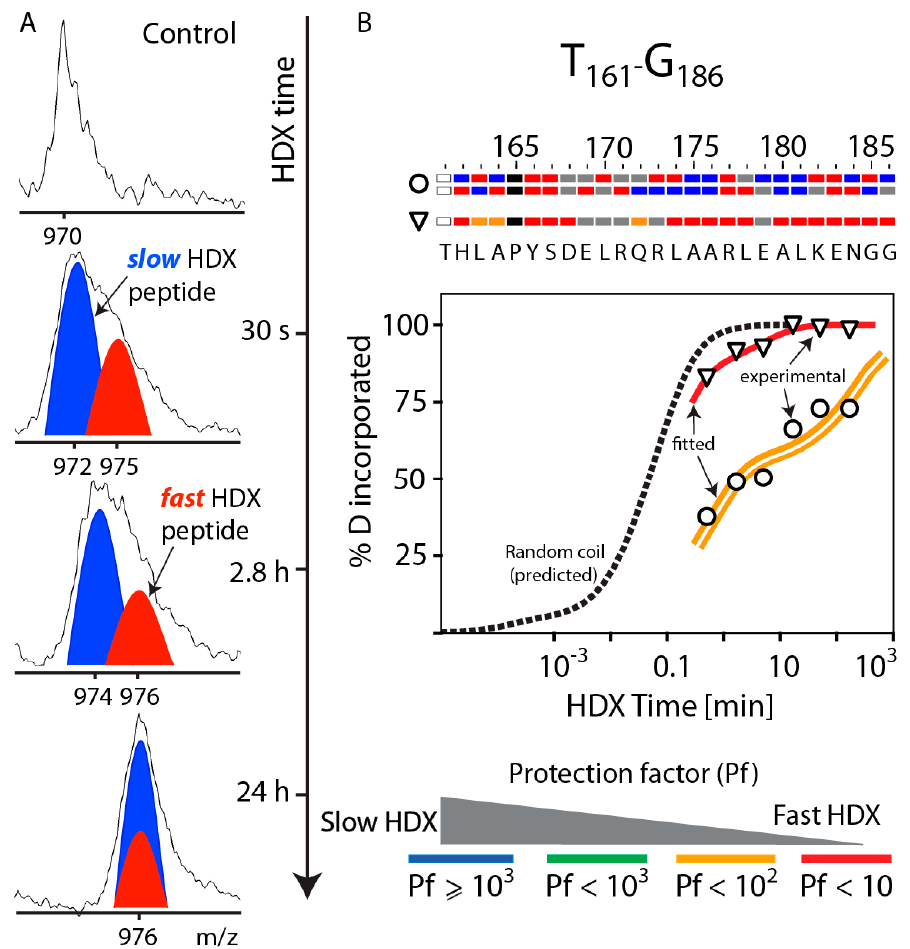
Figure 3. Bimodal and biphasic HDX kinetics of apoA-I peptide T 161 –G 186 in rsHDL. ( A ), MS spectra at various HDX times were “partitioned” into “spectra” (colored cartoons) for slow (blue) and fast (red) H / D exchanging protein domains. The peak centroids for the two protein domains merged over time, as the slower HDX domain became fully deuterated. The abundance of the peptide corresponding to the slower HDX domain was estimated to be about twice that of the peptide corresponding to the faster HDX domain. ( B ), Kinetic analysis of the HDX-MS spectra: the dotted black line displayed D incorporation in the T 161 –G 186 domain of apoA-I if in random coil conformation. The experimental D incorporation for T 161 –G 186 were shown with open circles (slow HDX) and open triangles (fast HDX), and the stretched exponential functions fitted to the experimental values (open circles and triangles) were the red and orange curves, respectively. The fact that the slow exchanging domain produces peptides twice as abundant as those generated by the fast exchanging domain was indicated with a double line (orange) and was consistent with the idea suggested earlier that two of the three apoA-I polypeptide chains (T 161 –G 186 region) in rsHDL experience an interaction environment that leads to slow HDX. T 161 –G 186 exhibited both bimodal and biphasic HDX kinetics. A protein domain exhibited biphasic HDX kinetics when the amino acid residues within the domain exchanged H / D with di ff erent HDX rates. The HDX rate constants for the slow and fast HDX domains could be obtained by fitting the DI values to stretched exponential functions. The HDX protection factors (Pf) for amino acid residues in the T 161 –G 186 domain (in each apoA-I molecule) were shown color-coded in the bar chart at the top of the graph. The color-coding scheme is shown at the bottom and is as follows: red: Pf < 10, orange: 10 ≤ Pf < 100, green: 100 ≤ Pf < 1000, blue: Pf ≥ 1000; residues with unknown HDX behavior were colored grey. The T 161 –G 186 domain originating from the apoA-I dimer was predicted to exchange slower than the one located in the hairpin chain, possibly because apoA-I dimerization reduced the dynamics of its